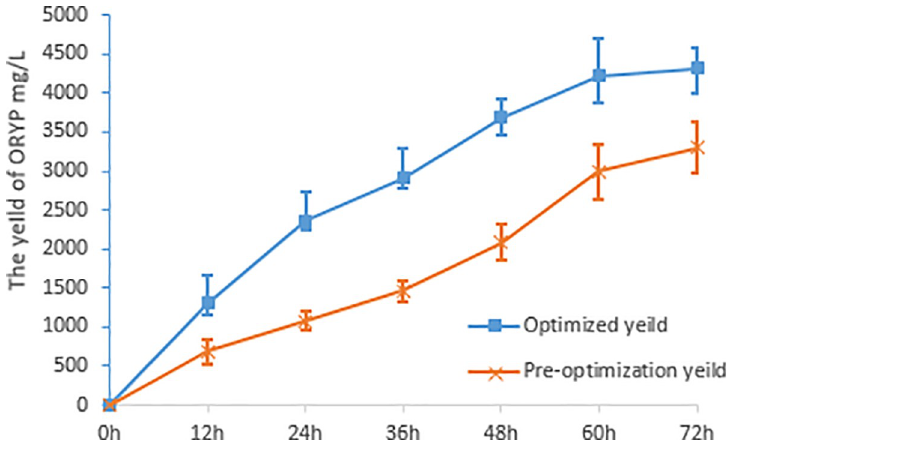
Fig 4. The MRYP yields of optimized conditions and pre-optimization.